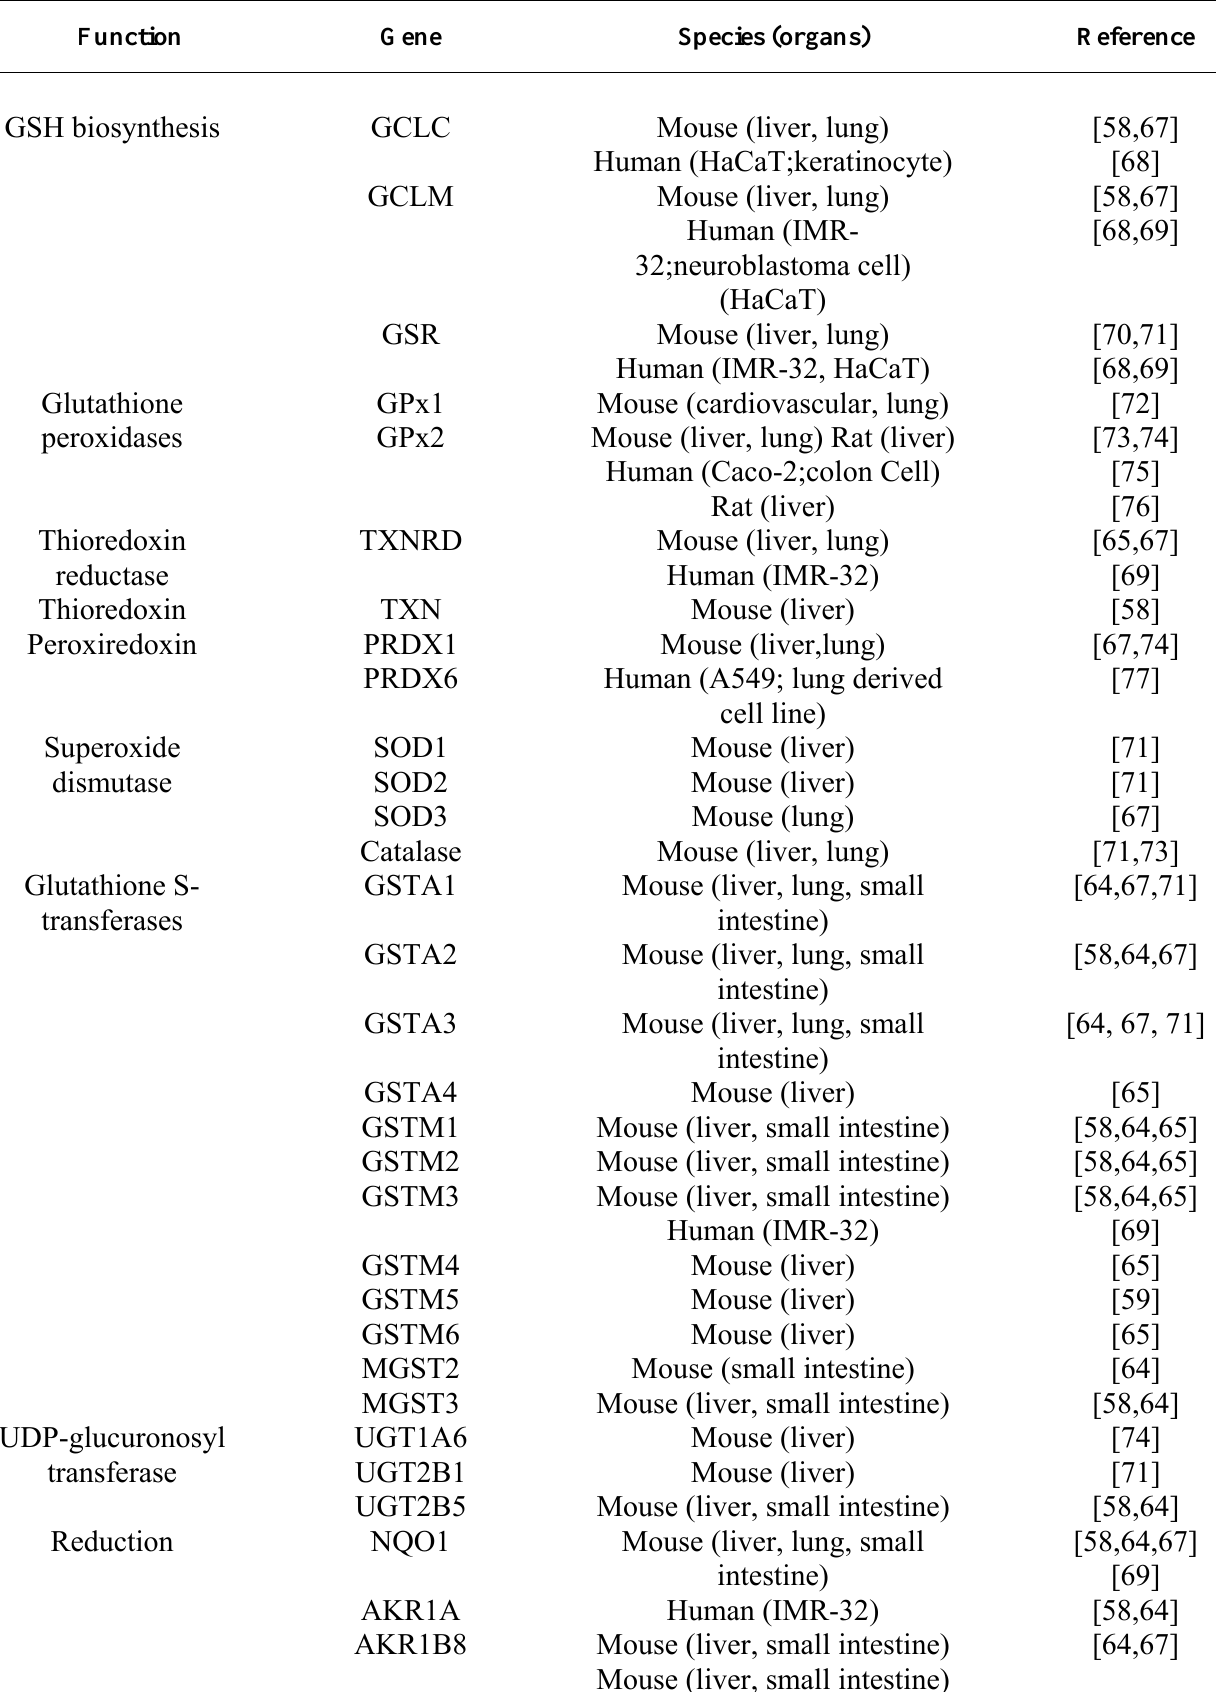
Table 1. Antioxidant genes regulated by